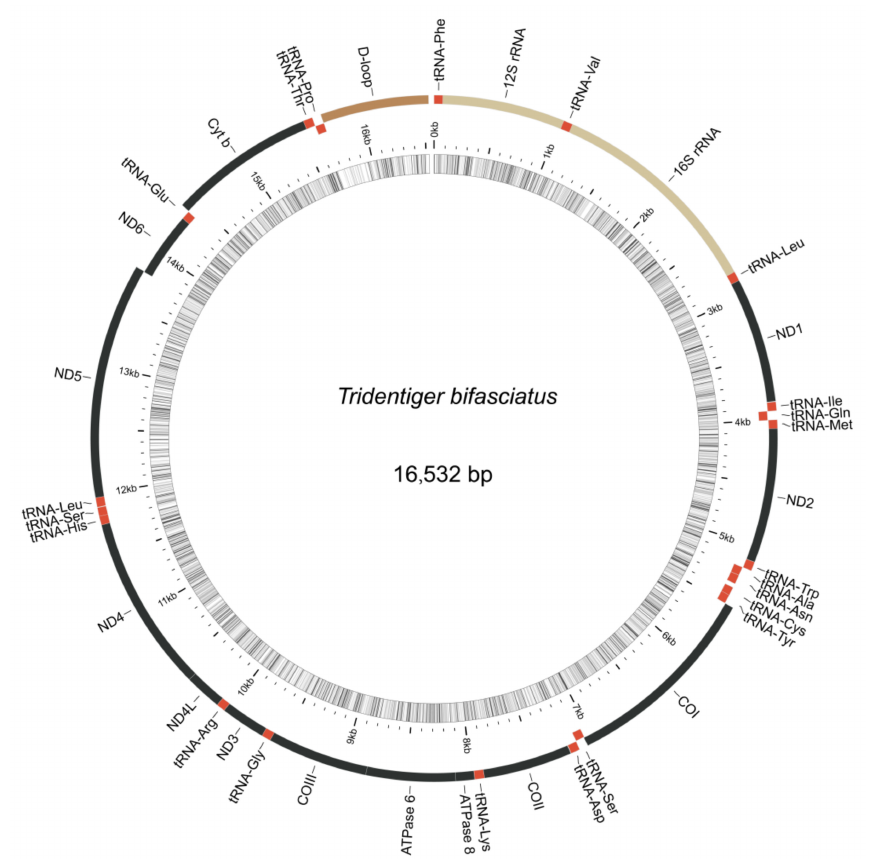
Figure 8. Mitochondrial genome organization of the shimofuri goby. Note: photo of the shimofuri goby from fishbase database (https://www.fishbase.de/, accessed on 27 April 2022), taken by Suzuki, Toshiyuki.